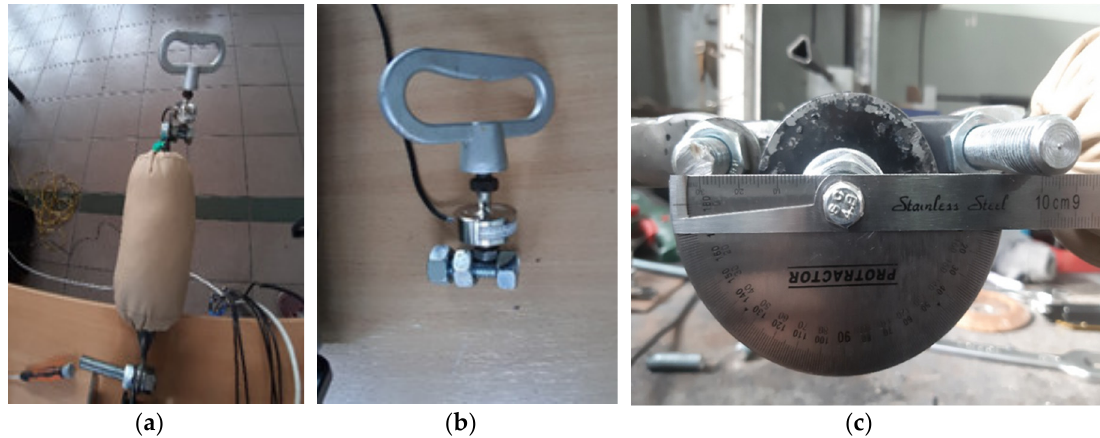
Figure 12. Measurements of basic parameters in the designed joint: ( a ) measurement of the resistance moment in the joint, ( b ) strain gauge for measuring the force in the joint, ( c ) measurement of the angle in the joint.